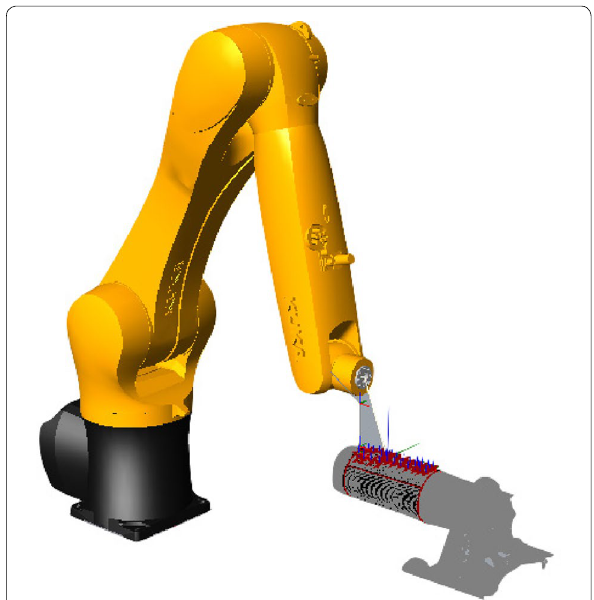
Fig. 3 Robot toolpath generation with KUKA|prc (Robots in